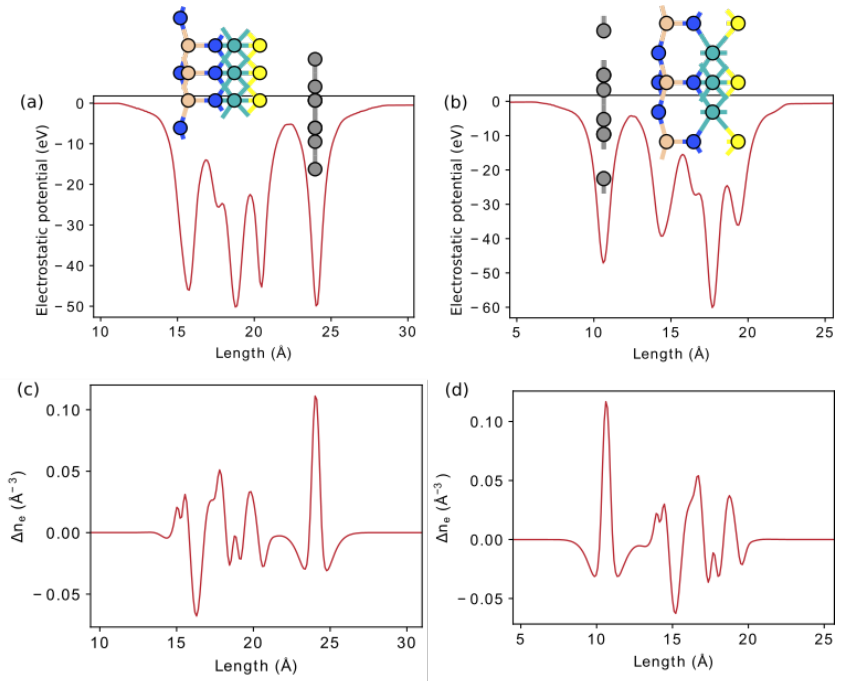
Figure 10. Electrostatic potential and electron difference density for vdW heterostructure S- MoSiN 2 /graphene ( a , c ) and graphene/S-MoSiN 2 ( b , d ).